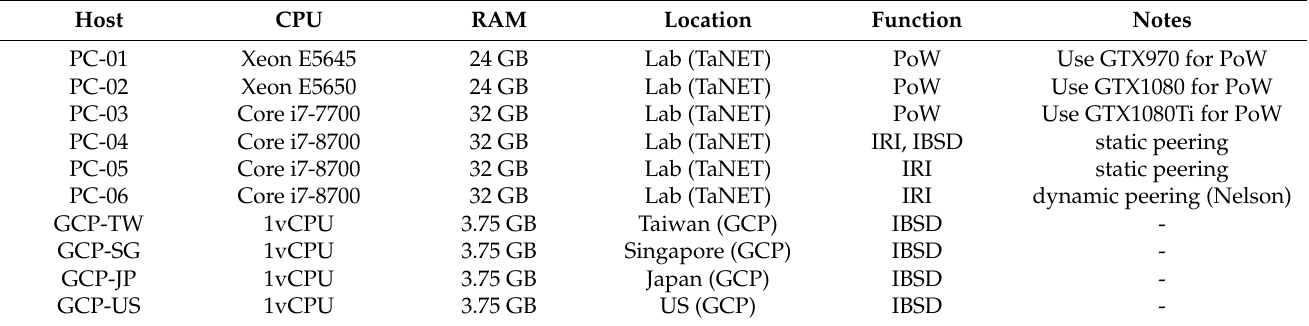
Table 1. Resources used in performance